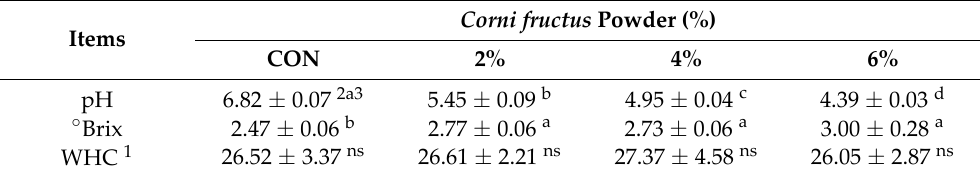
Table 4. Changes in pH,